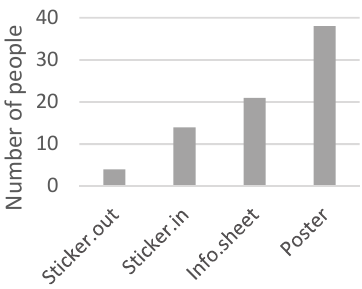
Figure A25. Most useful type of new information, second survey (77 individuals).